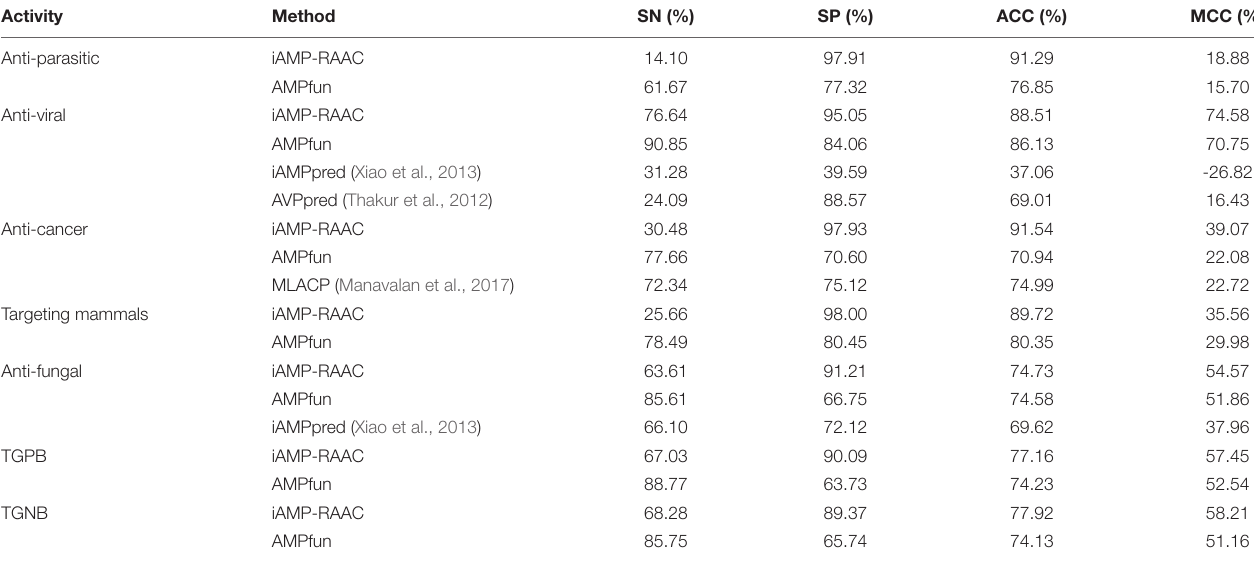
TABLE 6 | Performance comparisons of iAMP-RAAC and other methods on independent test set in DS2 in the seven different AMP functional activities.